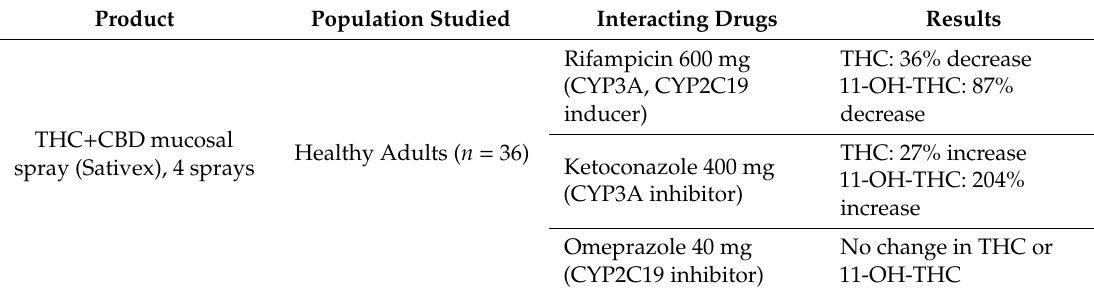
Table 2. In vivo pharmacokinetic drug–drug interaction study of Sativex